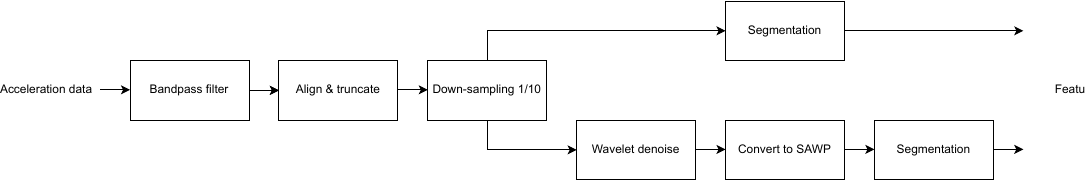
Figure 4. Signal-processing